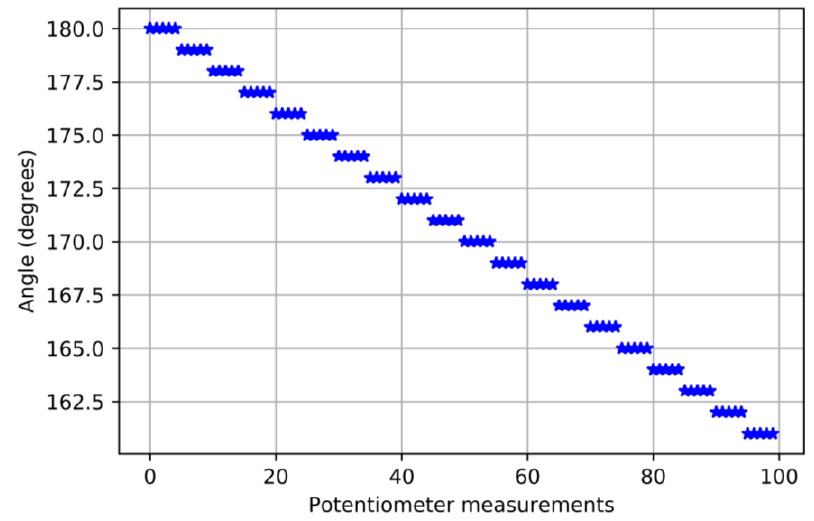
Figure 10. Mapping of the potentiometer values measured with the angle reached by the motor.